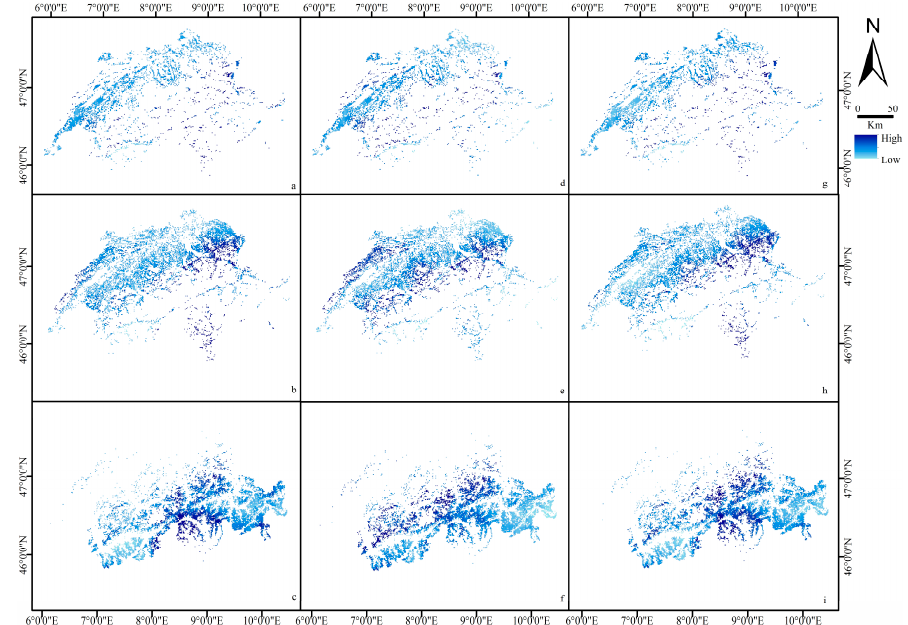
Figure A2. Spatial variability of yearly-accumulated precipitation: ( a – c ) croplands (455–3490 mm / year), croplands / natural vegetation mosaic (469–3472 mm / year), and grasslands (534–3825 mm / year), respectively, for the year 2000; ( d – f ) croplands (530–2919 mm / year), croplands / natural vegetation mosaic (530–2676 mm / year), and grasslands (528–4008 mm / year), respectively, for the year 2007; and ( g – i ) croplands (382–2860 mm / year), croplands / natural vegetation mosaic (386–2793 mm / year), and grasslands (447–3245 mm / year), respectively, for the year 2010.